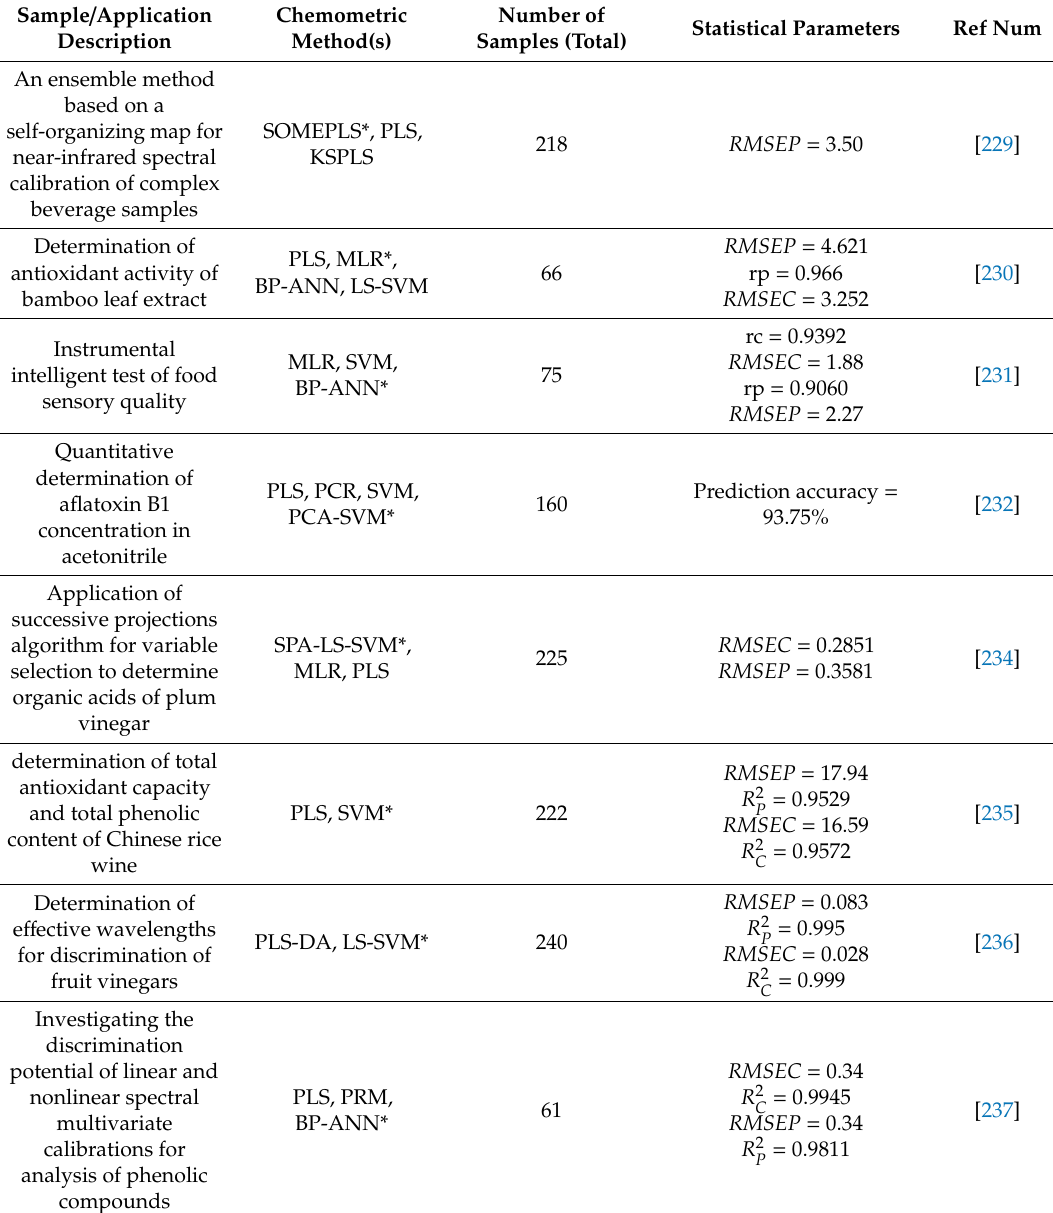
Table 14. Literature related to the use of chemometrics in prediction of properties of other food